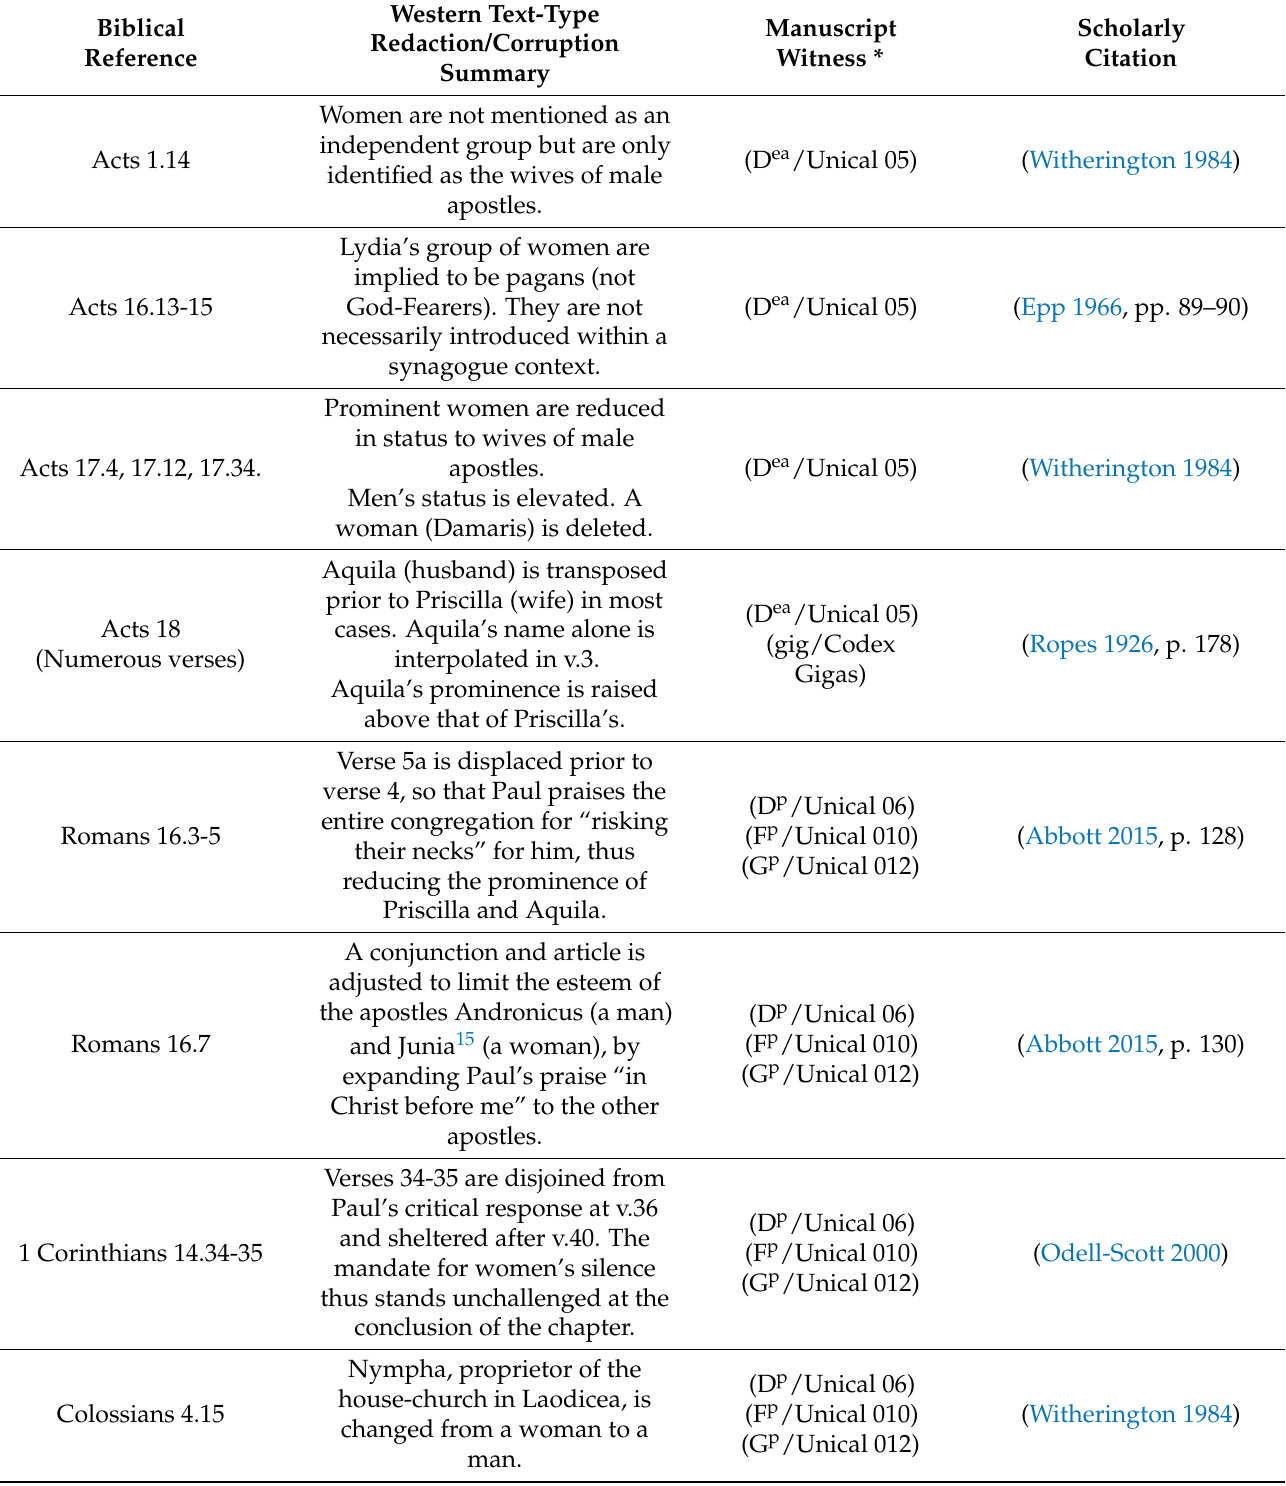
Table 3. Anti-feminist redactions in the Western text-type recensions of Acts and the